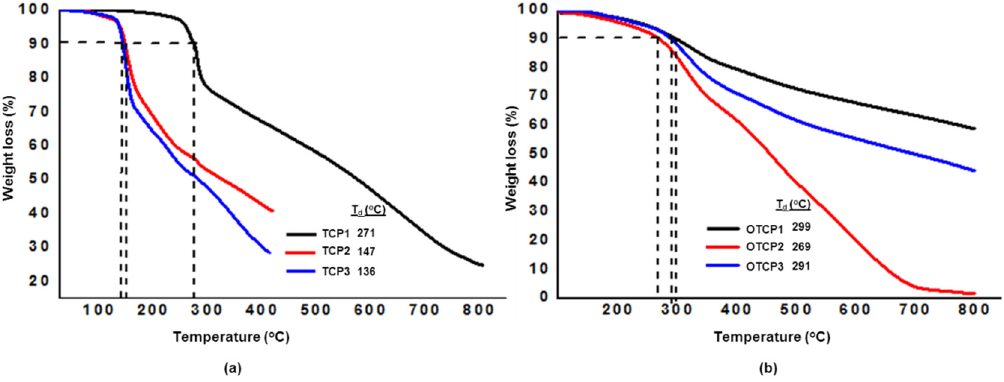
Figure 3. TGA thermograms of copolymers TCP1–3 ( a ) and OTCP1–3 ( b ), T d represents the temper-